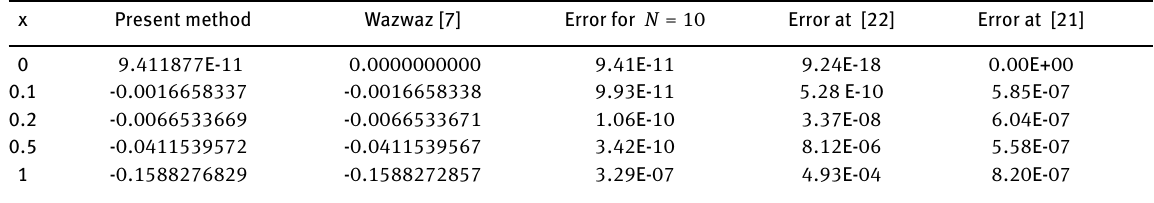
Table 2: Comparison of approximate solutions and error obtained by modified method with series solution wazwaz [7], newly advanced method Pandey [22] and Parand [21] for Example 5.